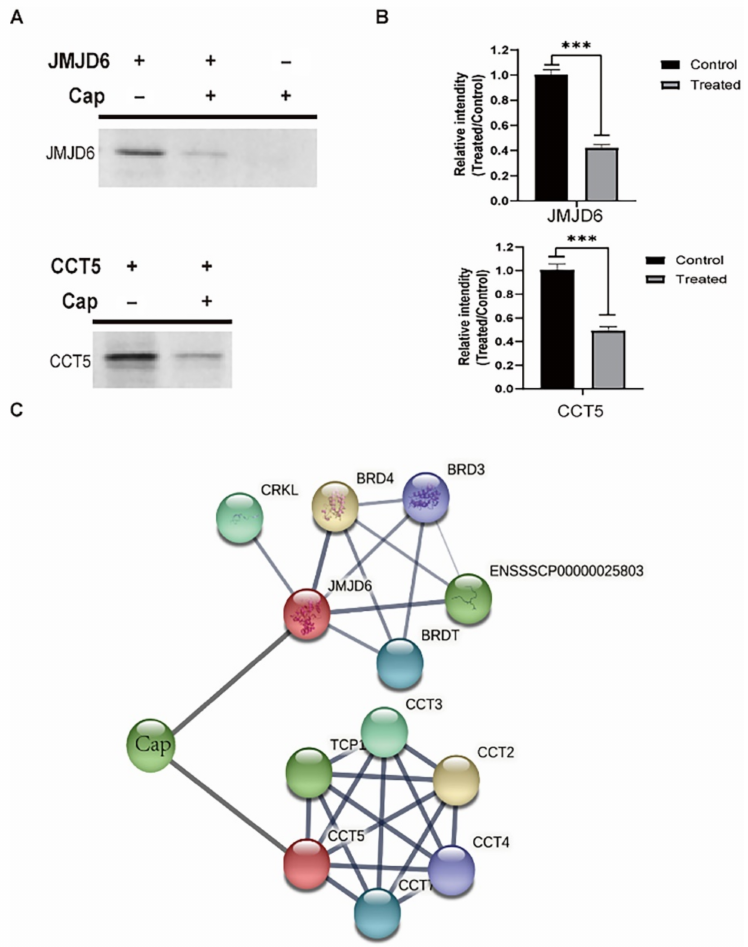
Figure 6. The in vitro reaction assays and the PPI networks. ( A ) SDS-PAGE analysis the in vitro reaction that Cap digested JMJD6 and CCT5 at 37 ◦ C 30 min, respectively. ( B ) Statistical analysis of the deduction of JMJD6 and CCT5 due to the digestion of Cap. All data were obtained from at least three independent experiments ( p < 0.05, p < 0.01, *** p < 0.001). ( C ) The PPI networks of the PCV2 Cap with JMJD6 and